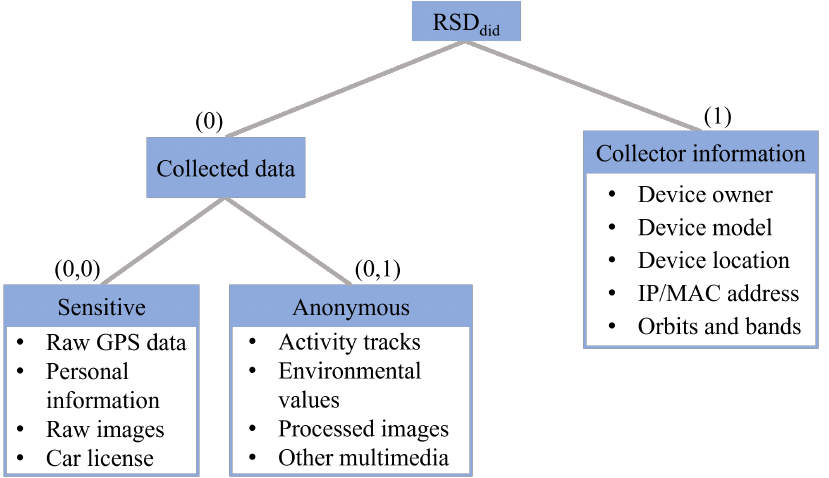
Figure 2. An exemplar attribute tree T did